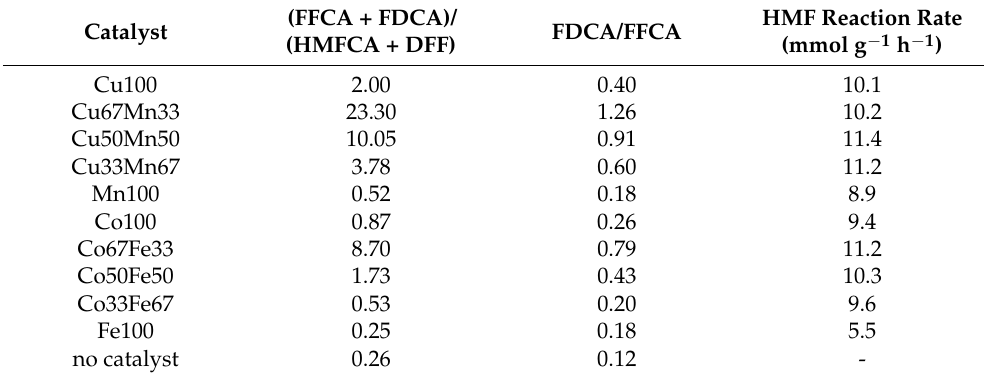
Figure 11. Conversion, selectivity, and carbon balance on Cu-Mn oxide catalysts and in the absence of a catalyst. The lines are a guide for the eye. Reaction conditions: TBHP/HMF 13 (molar ratio), HMF/catalyst 4 ( w / w ), 60 ◦ C, 3 h. Table 8. Product ratios and HMF reaction rates on different